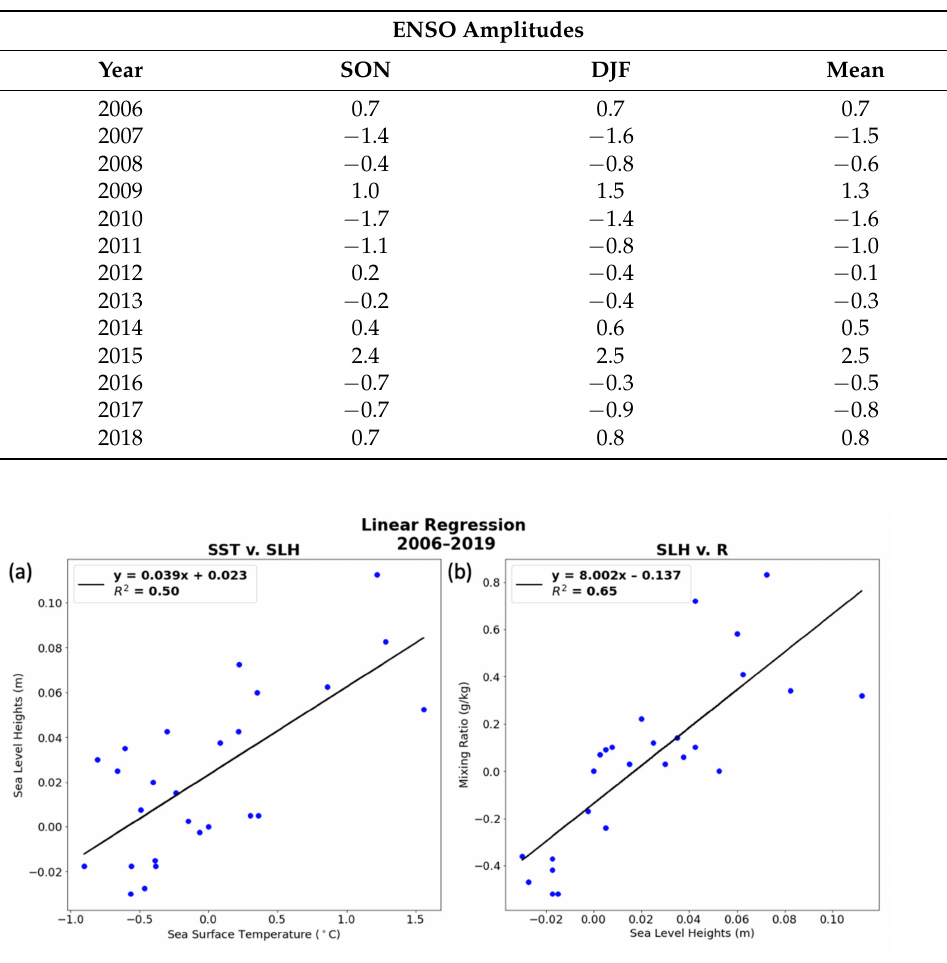
Figure 10. Linear regression of ( a ) sea surface temperature v. sea level heights and ( b ) sea level heights v. COSMIC mixing